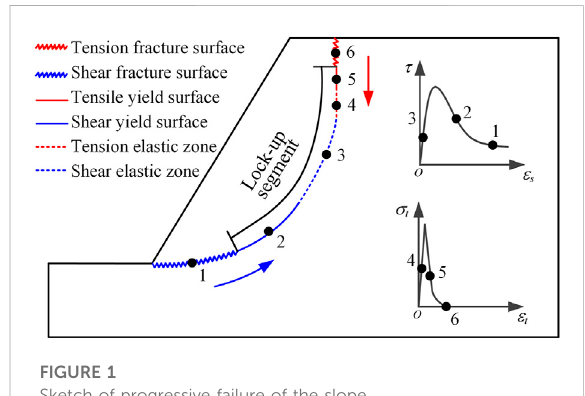
FIGURE 2 Sketch of stress concentration of slip surface. (A,B) Shear failure stage (A) and tension shear failure stage (B)